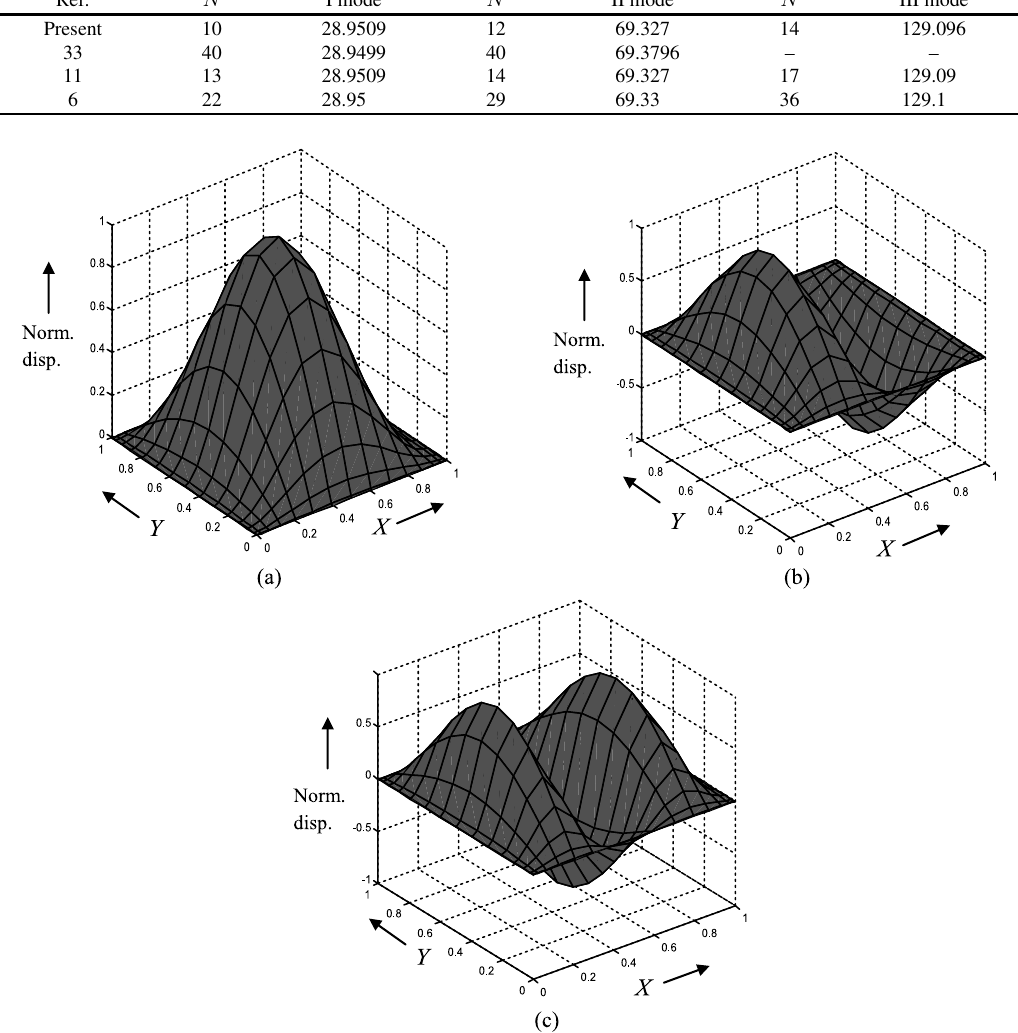
Fig. 10. Vibration modes of C-C plate (a) first mode (b) second mode (c) third mode; for a/b = 1 ,μ = β = 0 . 5 ,γ = 1 ,N ∗ 0 = 30